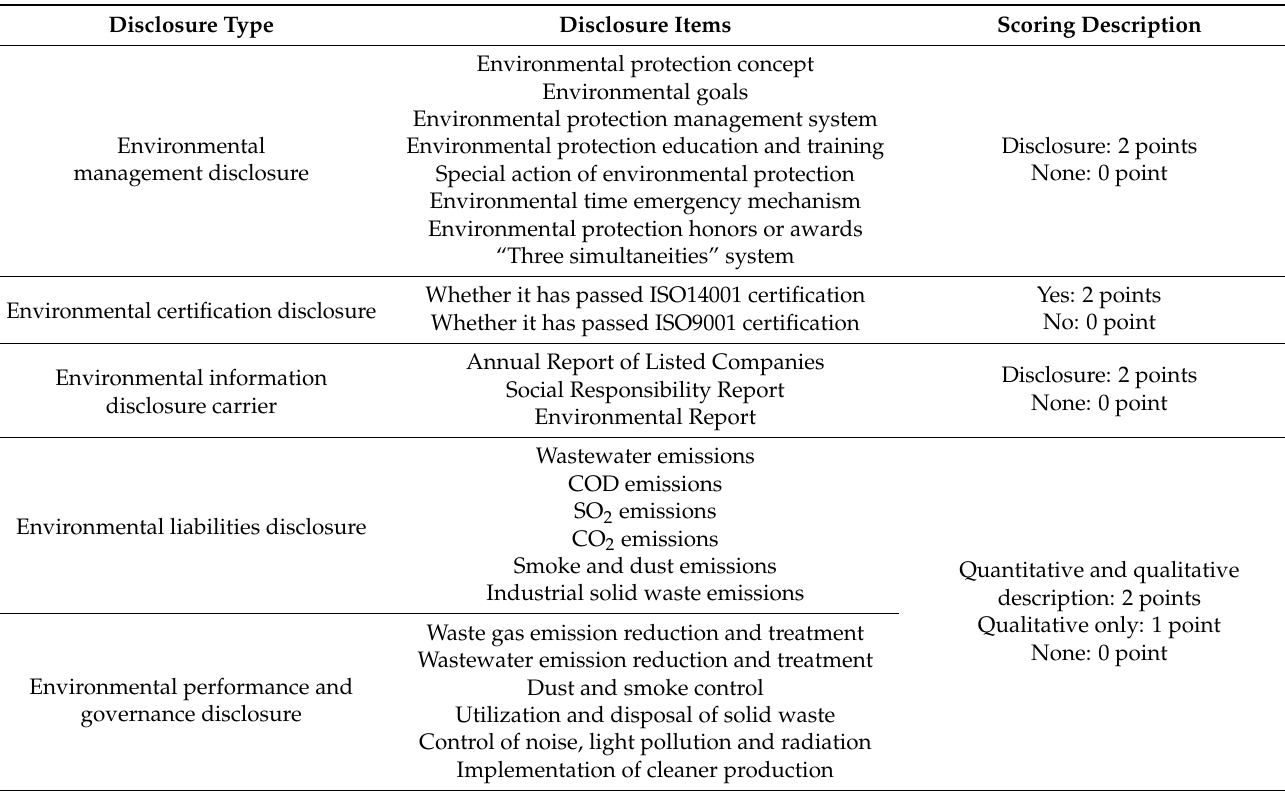
Table 3. The rural ecological environment governance efficiency index